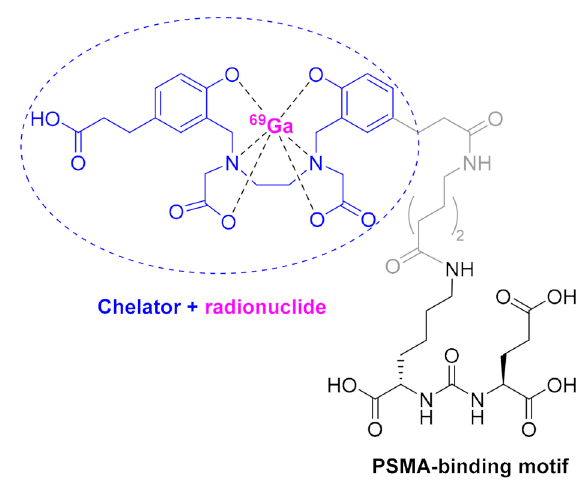
Figure 6. Structure of Ga-68 PSMA-1.